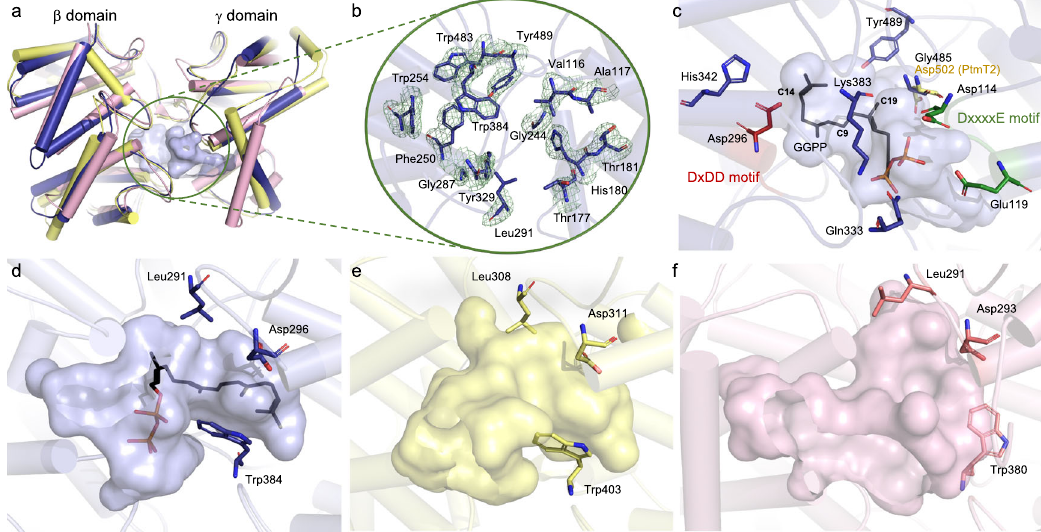
Fig. 2 Structure of Tpn2. a Overall βγ didomain structure of Tpn2 (PDB ID 7XKX, blue) aligned with PtmT2 (PDB ID 5BP8, yellow) and Rv3377c (PDB ID 6VPT, pink). The active site pocket of Tpn2 is circled in green. b Hydrophobic residues found in the active site pocket of Tpn2. The σ A-weighted difference ( mF o − DF c ) omit map for Tpn2 with a 3 σ contour is shown in green mesh. c Proposed binding mode of GGPP in the active site of Tpn2. C14 of GGPP lies 3.2 Å away from the carboxylate side chain of D296. G485, and the corresponding D502 in PtmT2, lie 3.6 Å from C19 of GGPP. Comparisons of the active site pockets of Tpn2 ( d ), PtmT2 ( e ), and Rv3377c ( f